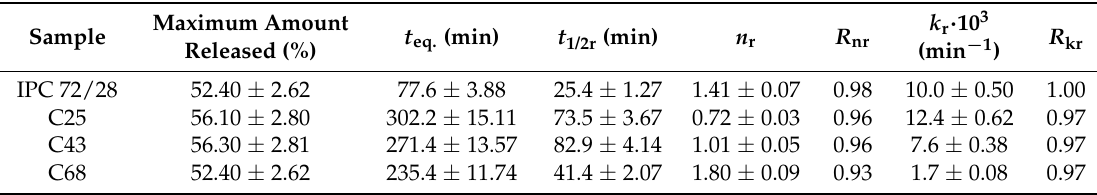
Table 5. In vitro drug release characteristics, including kinetic parameters ( n r and k r ) of THP from IPC and graft copolymers at 37 ◦ C and pH